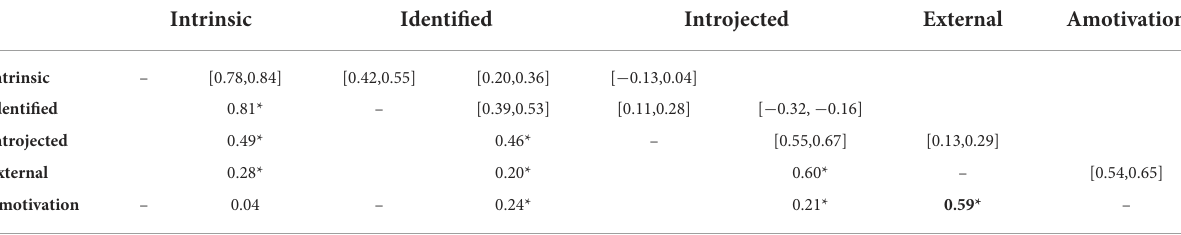
TABLE 4 Study 1 correlations among the five motivation subscales (below the diagonal) and 95% confidence intervals (above the diagonal).